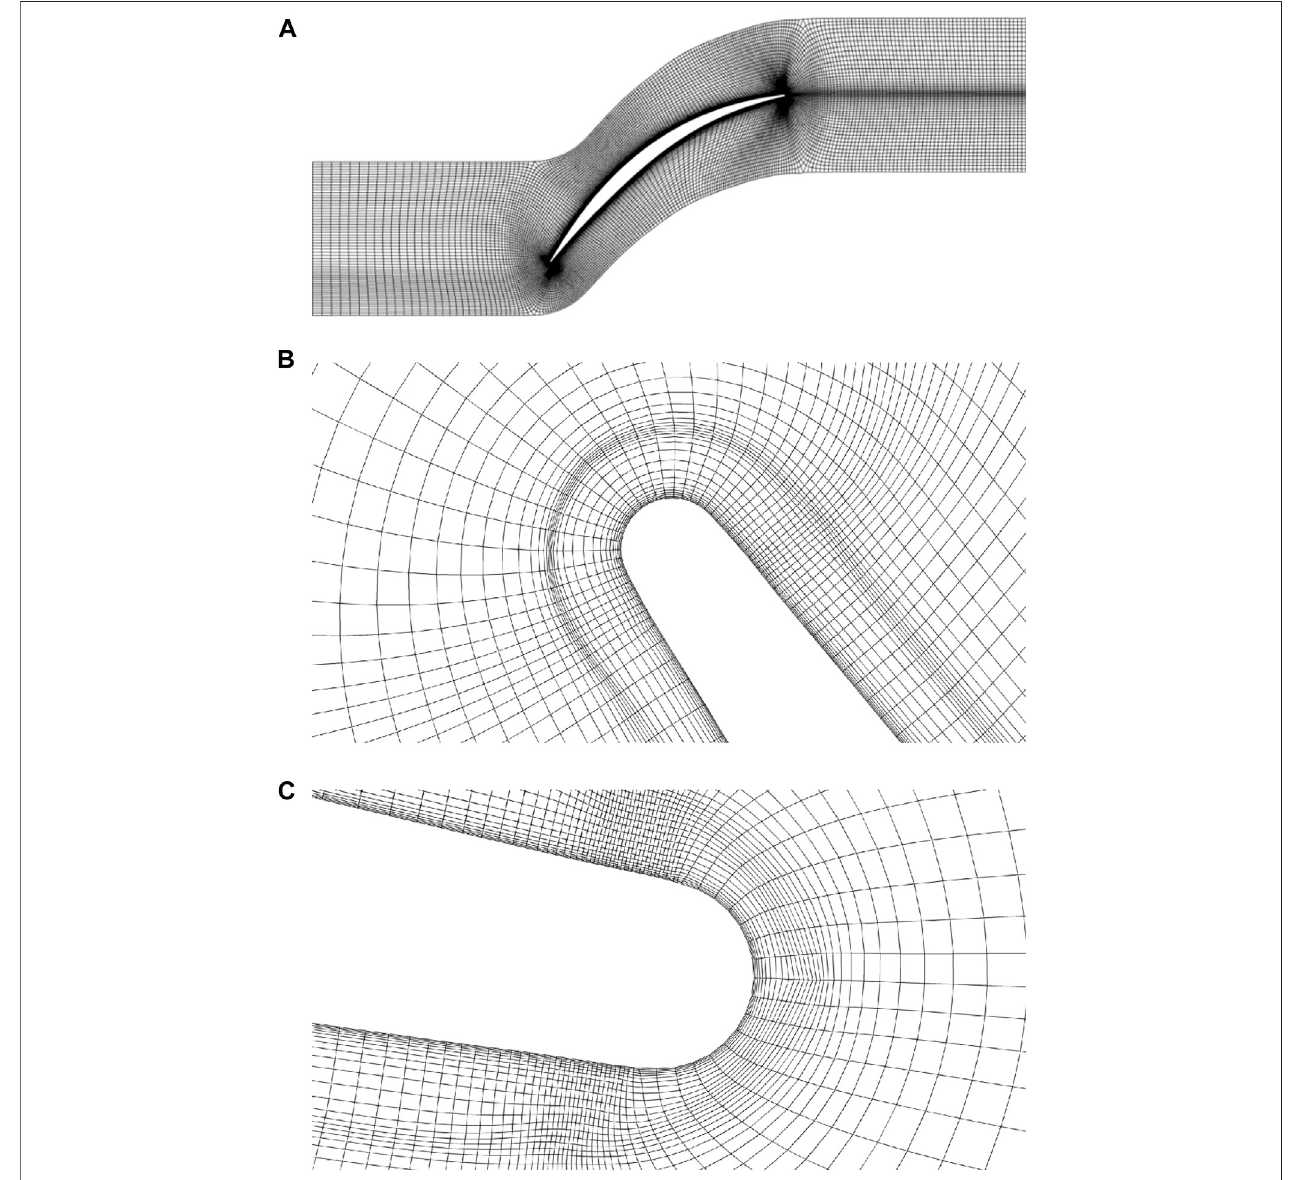
FIGURE 4 | Con fi guration of calculation mesh grids (A) Grids diagram; (B) Mesh grids at the leading edge; (C) Mesh grids at the trailing edge.